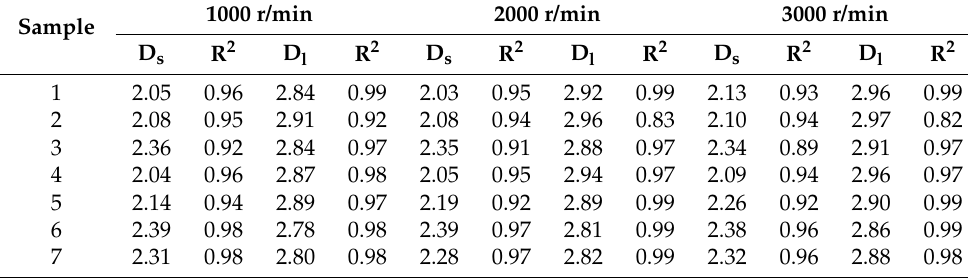
Figure 12. Plot of lg(f r ) versus Lg( T 2 ) using NMR from Sample 3. ( A ) the removed water distribution; ( B ) fractal curve of the removed water. Table 6. Fractal Dimensions of the residual water from NMR in different centrifugal